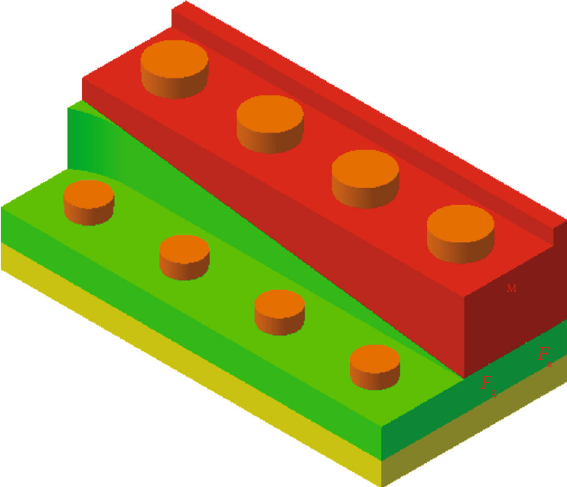
Figure 10: The 3D model of the 10th segment model.